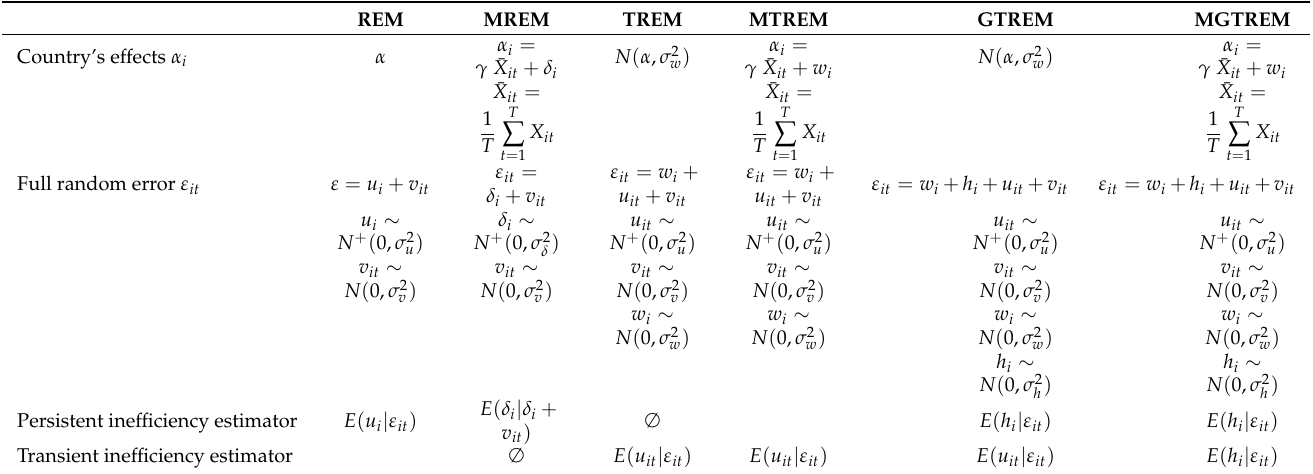
Table A1. Econometric specification of SEDF: effects, error term and